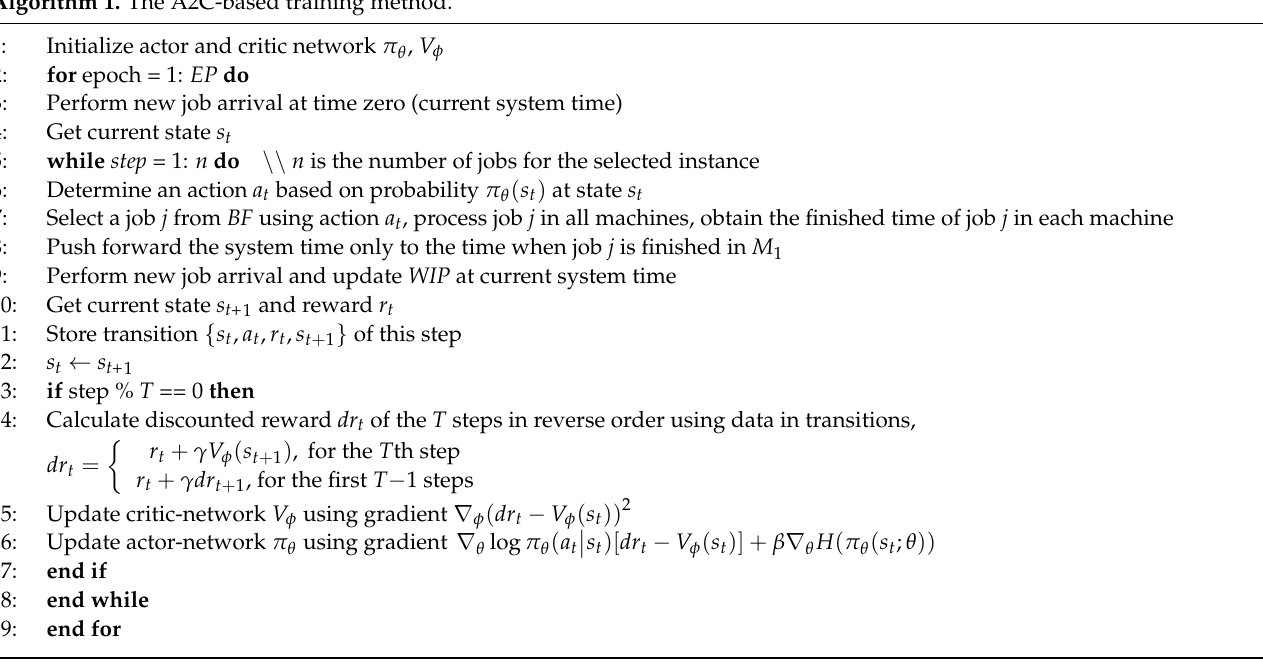
Algorithm 1. The A2C-based training